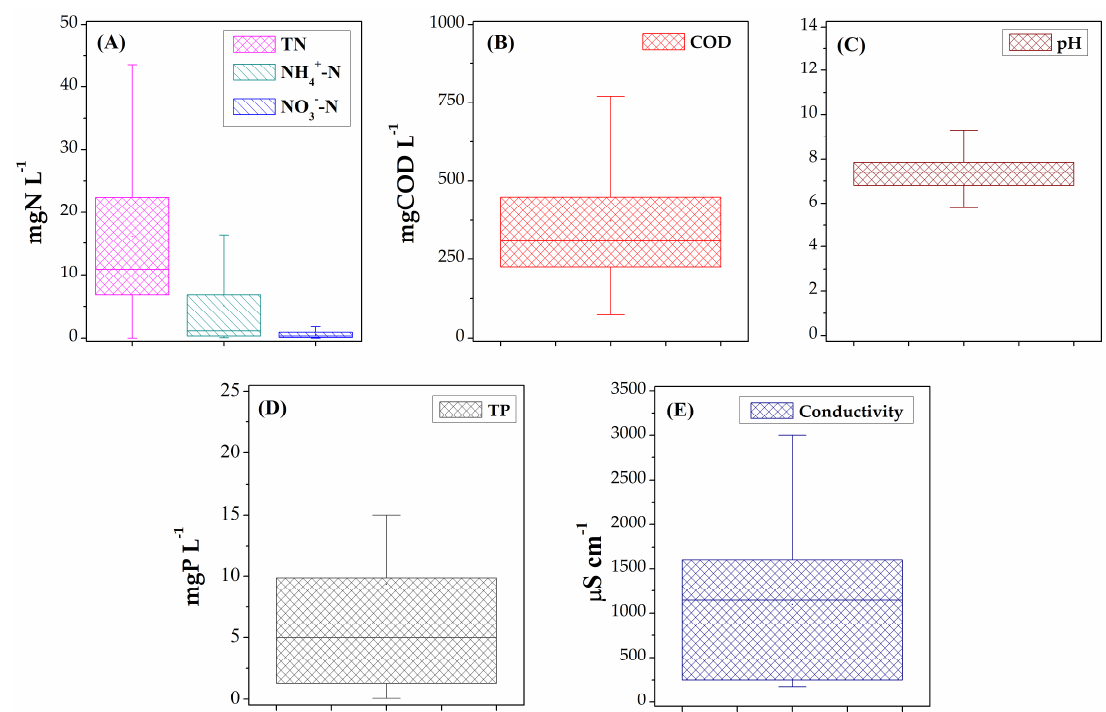
Figure 2. Chemical and physical parameters in greywater reported in the literature. Error bars represent the 25th and 75th percentiles. ( A ) Total nitrogen (TN), ammonia and nitrate nitrogen concentration; ( B ) Chemical oxygen demand (COD); ( C ) pH; ( D ) total phosphorus (TP); ( E ) conductivity. The list of the works consulted for the preparation of the figure is available in the Supplementary Materials. Table 1. Characteristics of the synthetic microbial fuel cell (MFC) greywater (GW) influents. COD: chemical oxygen demand; TN: total nitrogen; TP: total